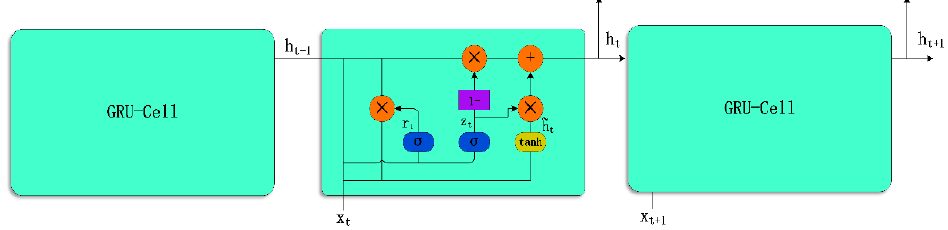
Figure 5. GRU Figure 5. GRU model.